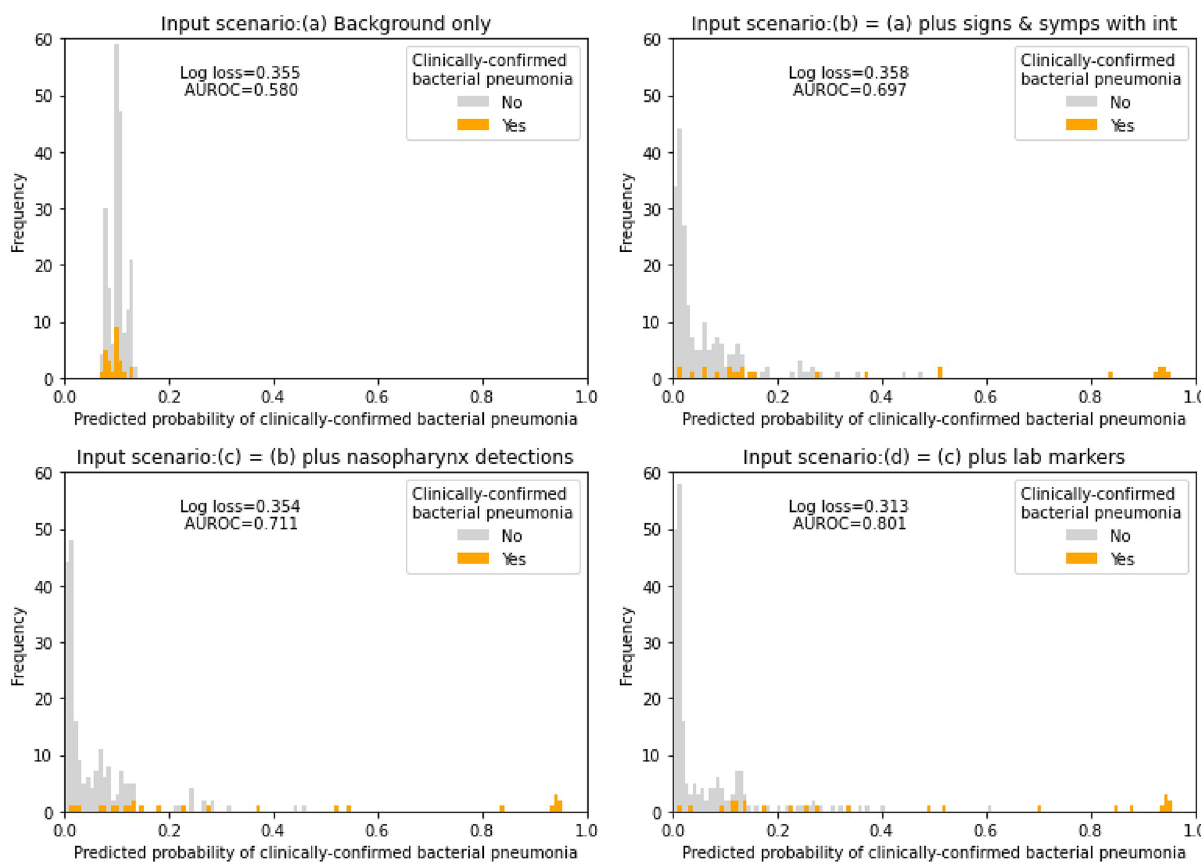
Fig 7. The performance of BN v4.5. Predicted probabilities of clinically-confirmed bacterial pneumonia are compared with the final observations (orange if yes) for four input scenarios, with mean log loss and AUROC based on 10-fold cross-validation. For each scenario, available information from each participant was entered as input for the BN to predict the clinically-confirmed bacterial